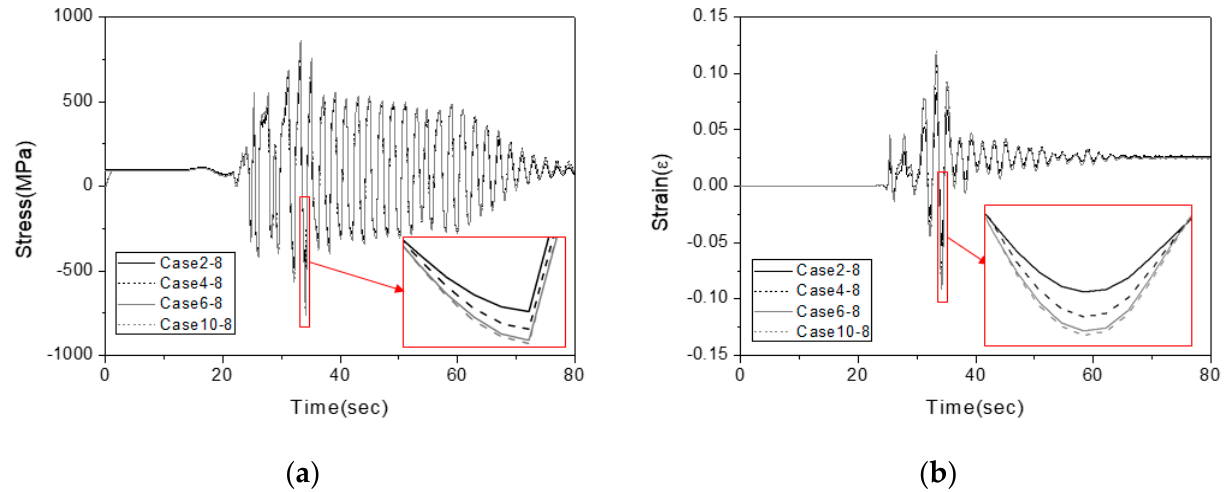
Figure 11. Comparison according to the change in the lengthwise element size: ( a ) stress; ( b ) strain.